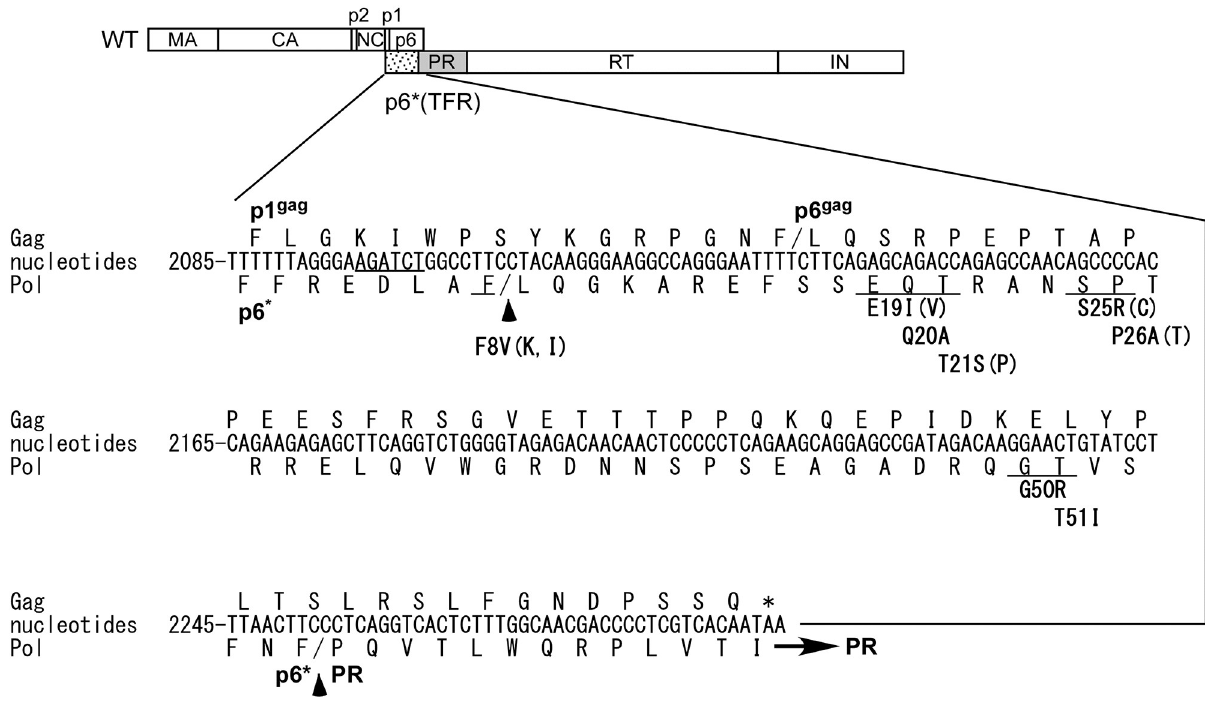
Fig 1. Schematic representation of HIV-1 Gag and Gag-Pol constructs. Indicated are HIV-1 Gag protein domains MA (matrix; p17), CA (capsid; p24), NC (nucleocapsid; p7), p1, p6, pol-encoded transframe region (TFR) p6 � , PR, RT and IN. An overlapping reading frame sequence between p1gag- p6gag and p6 � and encoded amino acid residues are shown. Positions of mutated amino acid residues are underlined. Alternative substitution residues are in parentheses. Arrowheads indicate cleavages at the p6 � /PR junction and the F8/L9 putative internal cleavage site.